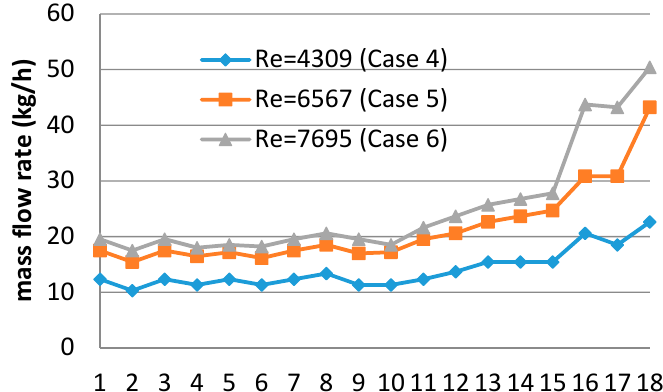
Figure 3. Experimental mass flow rate measurements in the riser tubes.